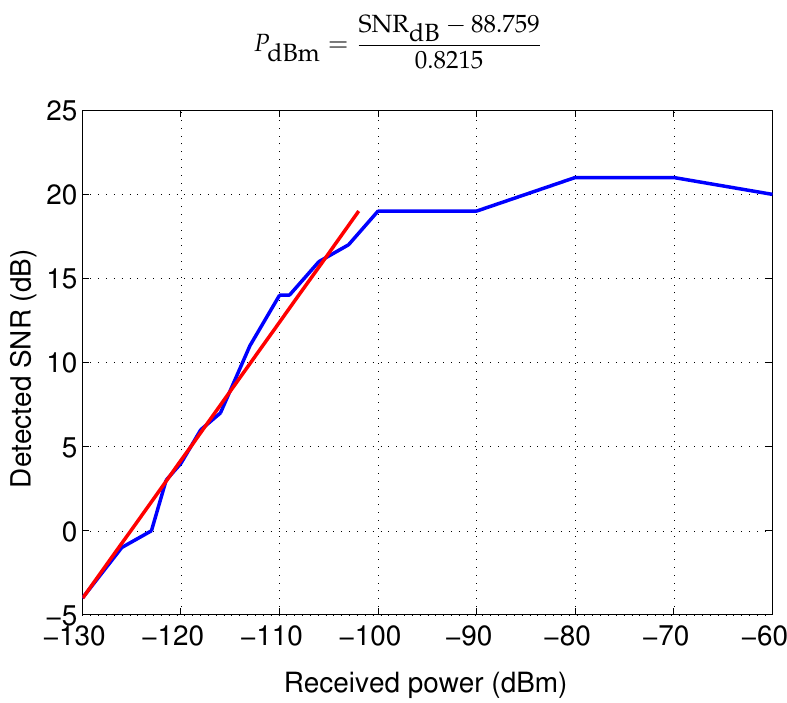
Figure 7. Calibration of the receiver’s signal-to-noise ratio (SNR)